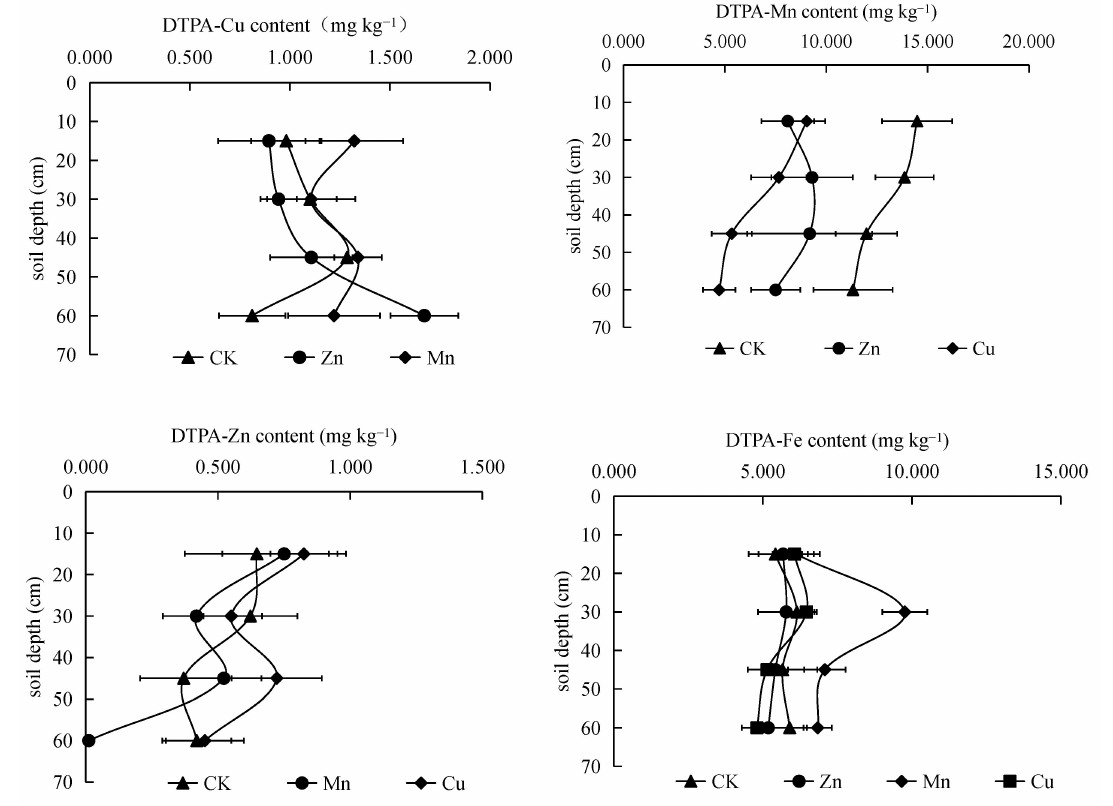
Figure 2. Interactions of long-term application of micronutrient fertilizers on the micronutrient availability. Values are means with standard deviations shown by the vertical bars (n =